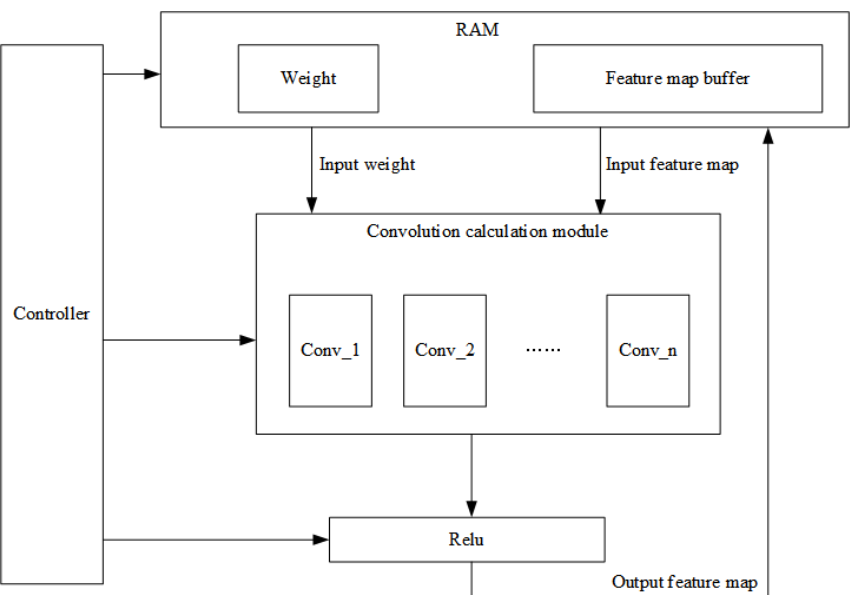
Figure 14. Convolutional parallel cyclic multiplexing structure.